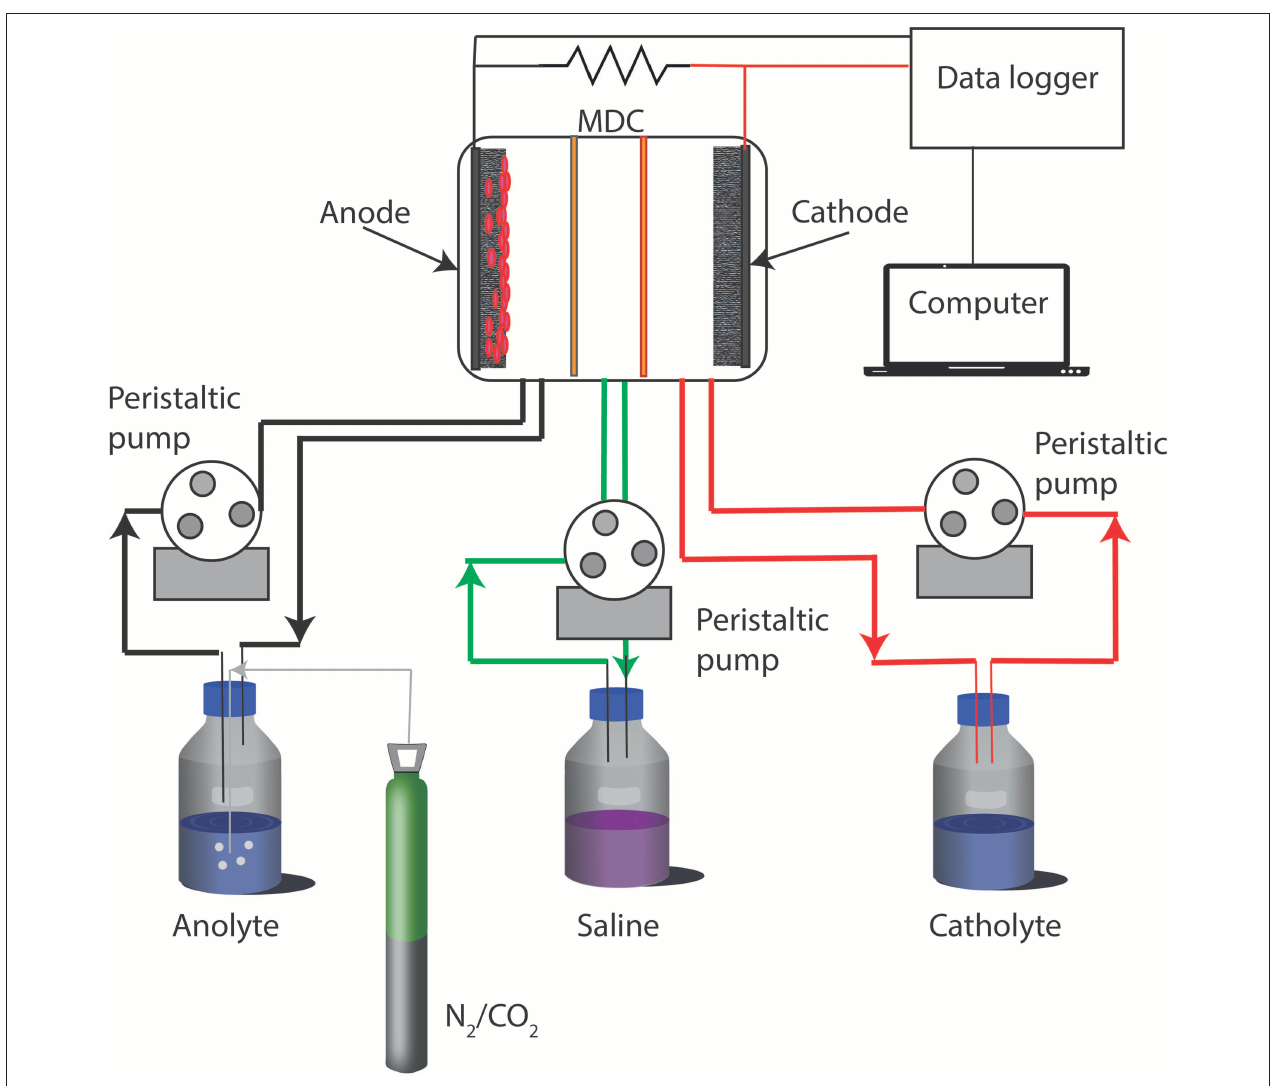
FIGURE 2 | Microbial Desalination Cells